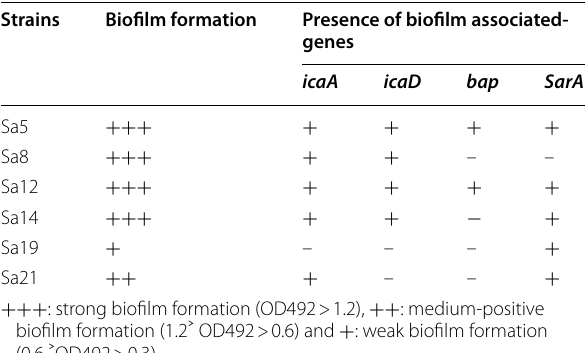
Table 5 Biofilm formation capability and presence/absence of genes associated with biofilm formation in MRSA strains isolated from clinical